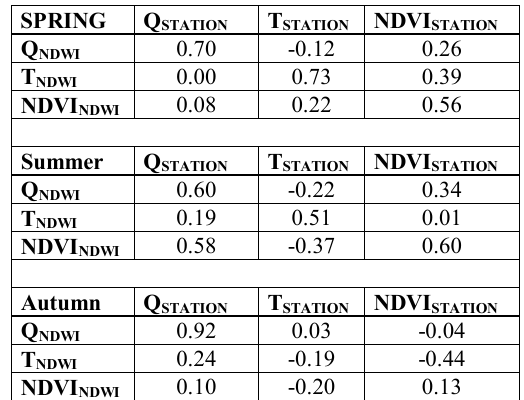
NDWI is differ significantly for different types of vegetation in the autumn season, due to that the coniferous forests remain green and deciduous begin to loose leaves. Therefore, NDWI